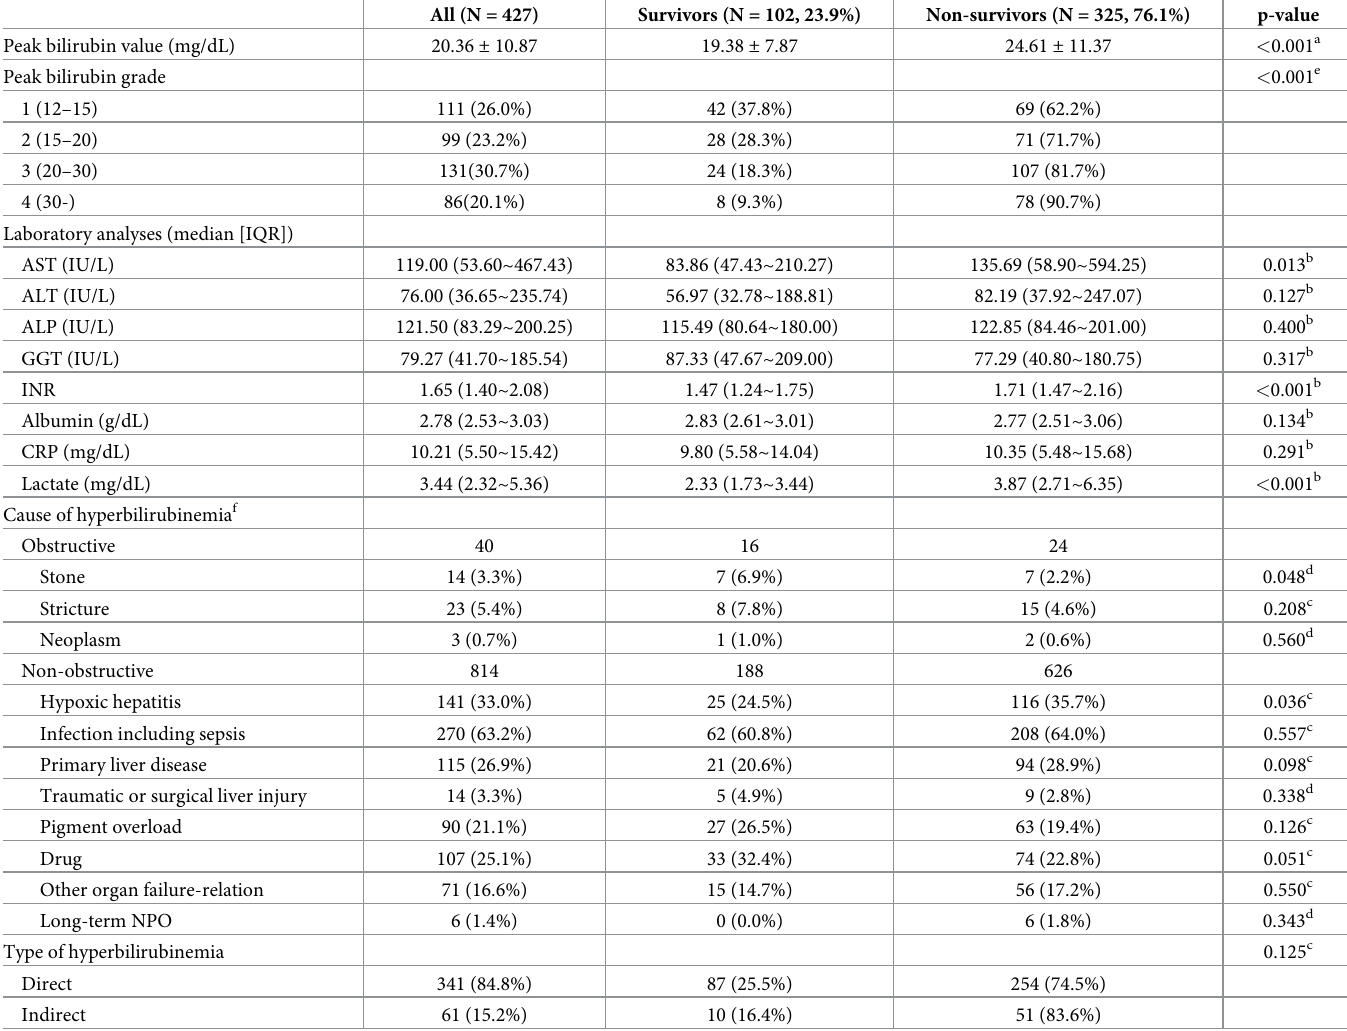
Table 2. Comparison of factors related to hyperbilirubinemia according to